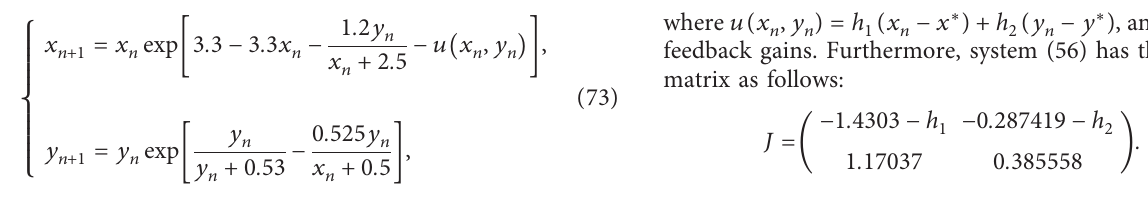
Figure 6: ((a), (b)).The Neimark–Sacker bifurcation diagram. (c) The maximum Lyapunov exponents for system (5) with r g � 2 . 7, b � 1 . 2,